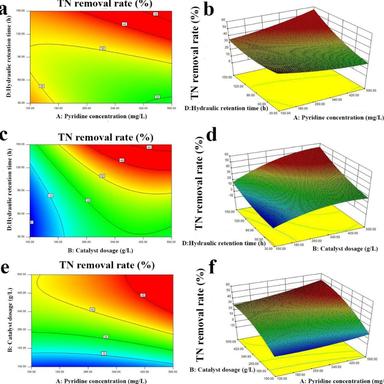
Response surface and counterplots for TN removal from pyridine wastewater. Effects of process parameters on the removal of TN: pyridine concentration and hydraulic residence time (a and b); catalyst dosage and hydraulic residence time (c and d); and pyridine concentration and catalyst dosage (e and f).